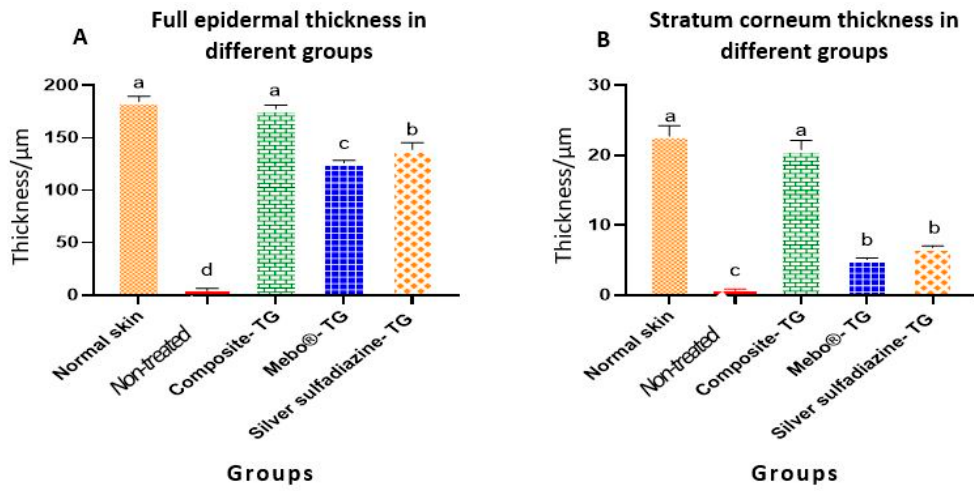
Figure 7. Full epidermal and stratum corneum thickness of normal rabbit skin and different treated groups of experimentally induced skin burns. The measured histological cuts per treatment = 9. Bars with different letters (a, b, c, and d) are significantly different at p ˂ 0.05.